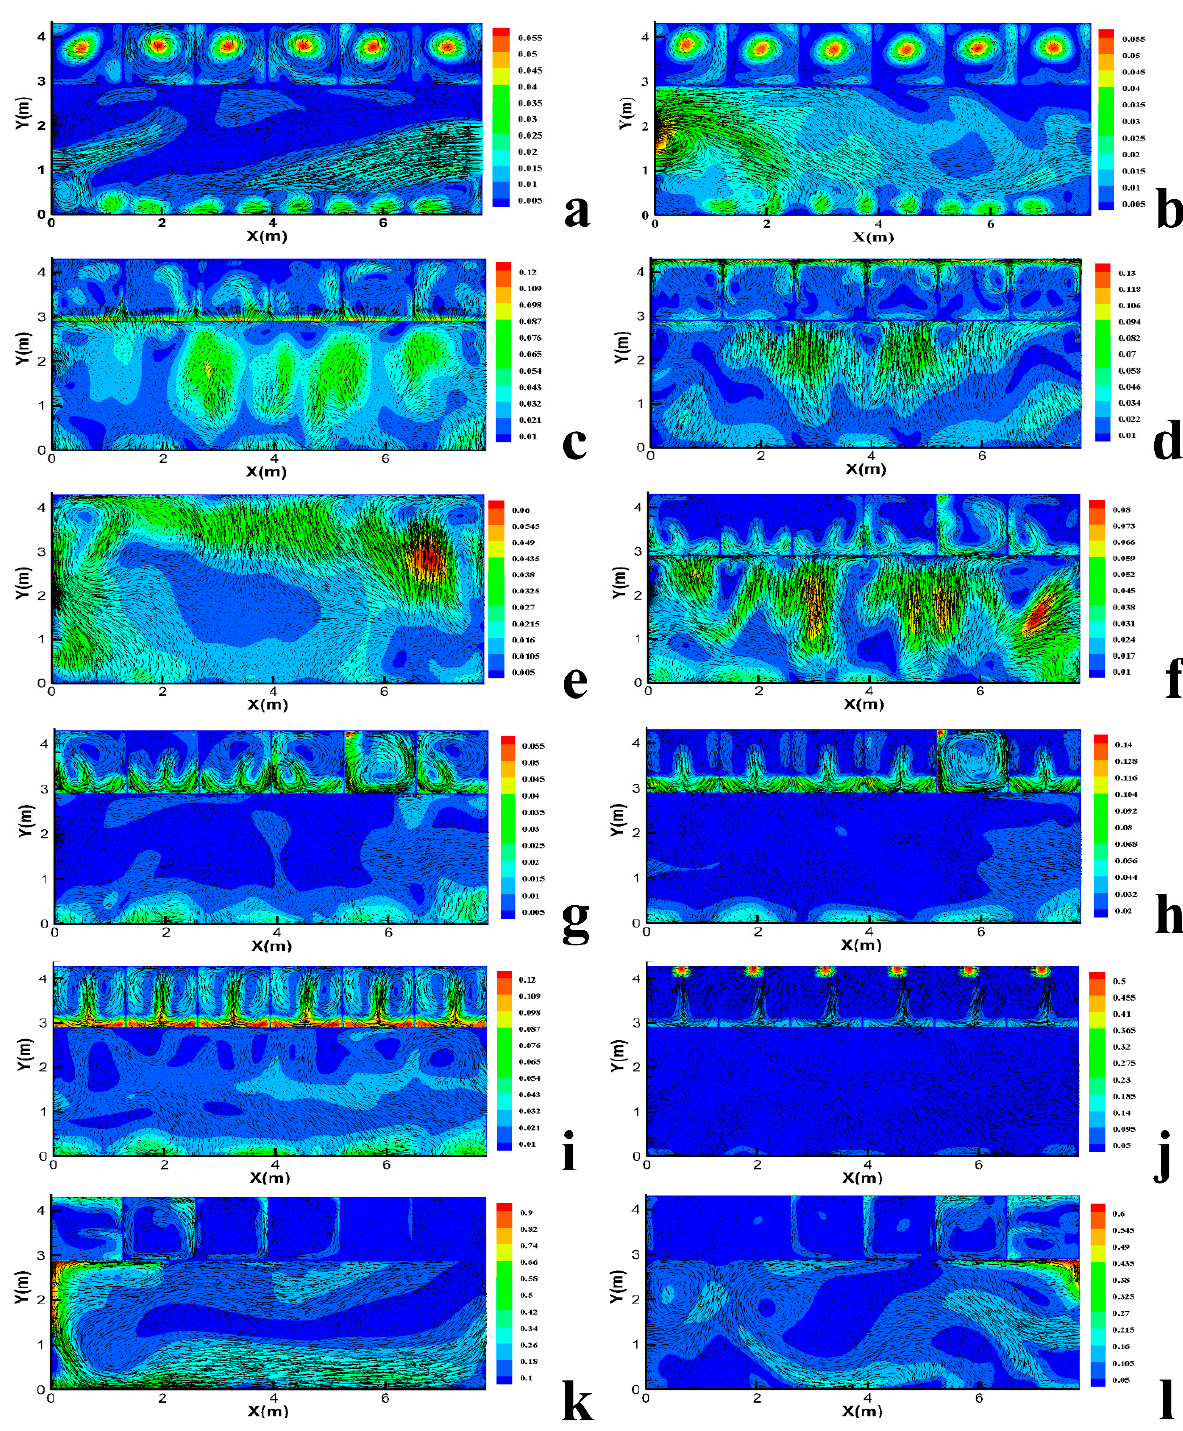
Figure 4. Velocity vector contours in different cases (Z = 1.5 m, ACH = 5): ( a – l ) MV-1–IJV-7. The normalized concentration value of IJV-1 is higher than IJV-2, which is 0.309. The two programs use the same ventilation method near the stall. IJV-1 provides air near the urinal, the concentration of pollutants in some areas near the urinal is relatively high, and the air supply has a weak ability to take away pollutants (Figure 3f). The flow lines in the middle of the toilet are relatively dense and have a high wind speed (Figure 4f). The nor- malized concentration values of IJV-3, IJV-4, and IJV-5 are 0.32, 0.326, and 0.312, respectively. The height of the air outlet of the three schemes is different. The pollutant concen- tration distribution law of the monitoring surface (Z = 1.5 m) is different (Figure 3h–j); the